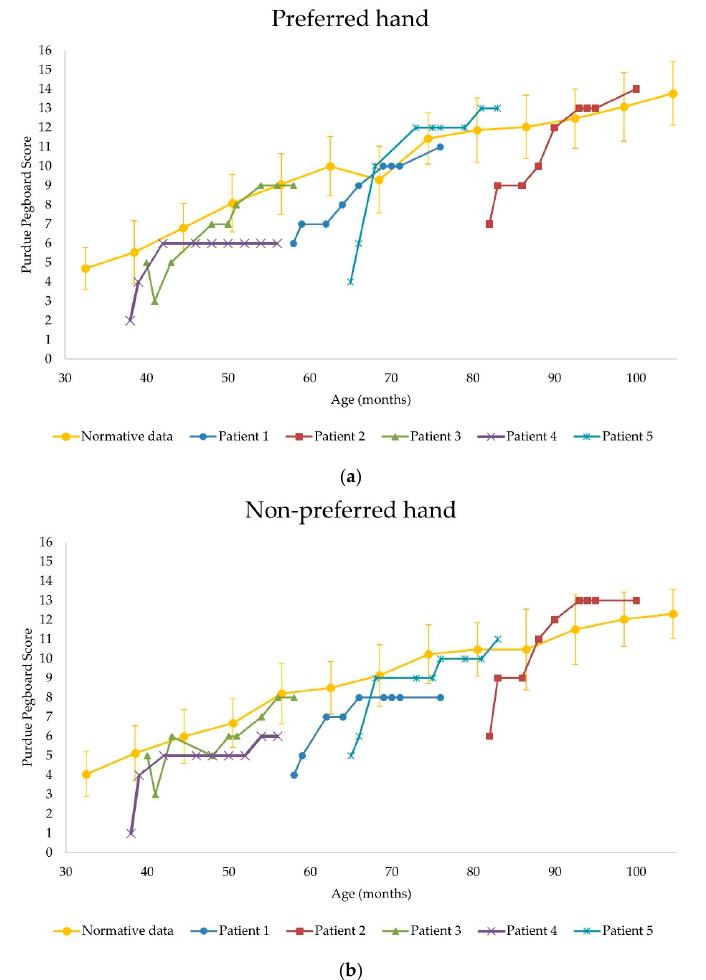
Figure 3. Comparison of Purdue Pegboard score changes in patients versus normative data. ( a ) Preferred hand; ( b ) non-preferred hand.